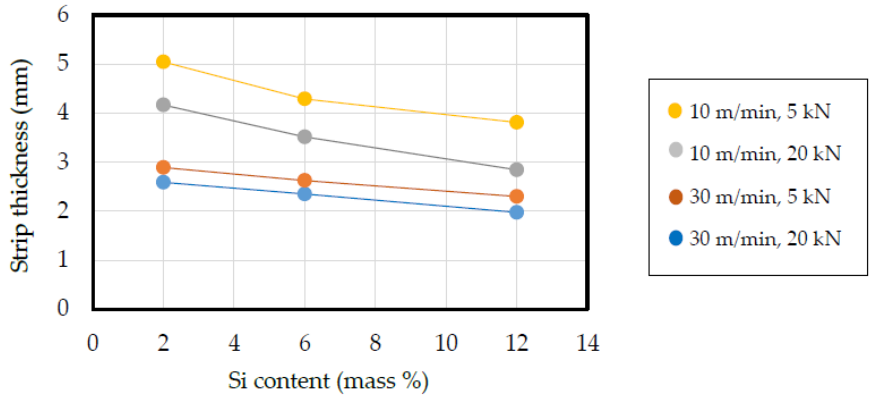
Figure 4. Effects of roll speed, roll load, and Si content on Al-Si strip thickness. Roll speed: 10 m/min and 30 m/min; roll load: 5 kN and 20 kN; Si content: 2%, 6%, and 12%.